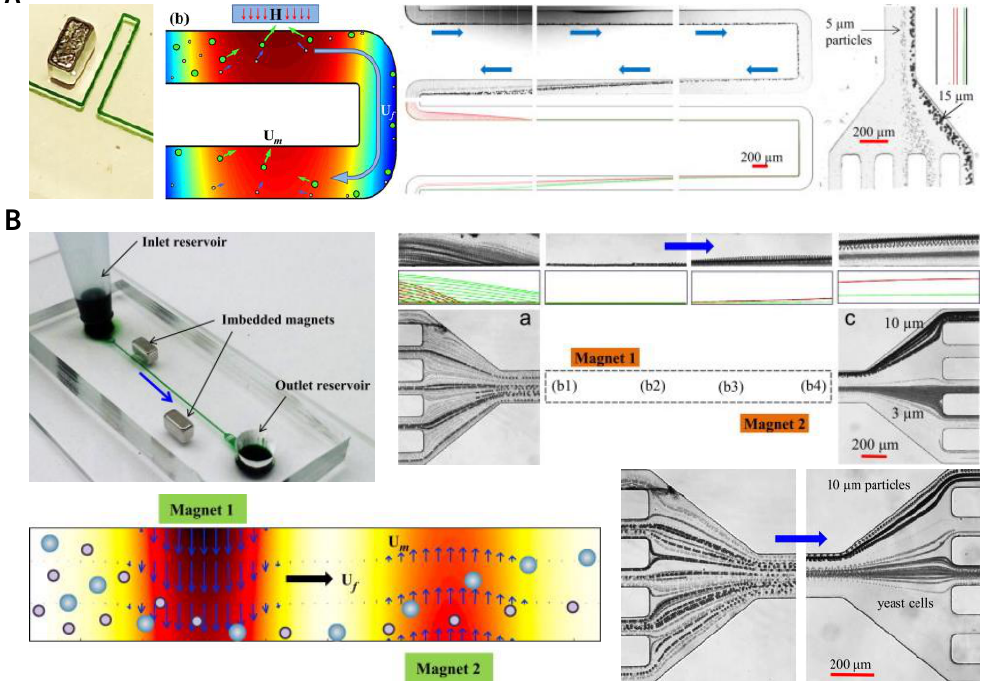
Figure 12. Sheath-free diamagnetic particle separation by size in the flow of magnetic fluids. ( A ) Picture of the microfluidic chip (left) and schematic showing the mechanism of diamagnetic particle separation in the flow of magnetic fluids through a U-shaped microchannel (middle). Adapted with permission from Liang and Xuan [141], © 2012 American Institute of Physics. Comparison of the experimental and numerical images of 5 µm and 15 µm PS beads in 0.5 × EMG 408 ferrofluid at different channel locations (right). Adapted with permission from Zhou et al. [142], © 2016 Elsevier B.V. ( B ) Picture of the microfluidic device (upper left) and schematic of the particle separation mechanism (lower left); comparison of the experimental and theoretical images of 3 µm and 10 µm PS beads in 0.05 × EMG 408 ferrofluid (upper right); streak images showing the separation of yeast cells and 10 µm PS beads at the inlet and outlet expansions of the microchannel (lower right). Adapted with permission from Zeng et al. [143], © 2013 Elsevier